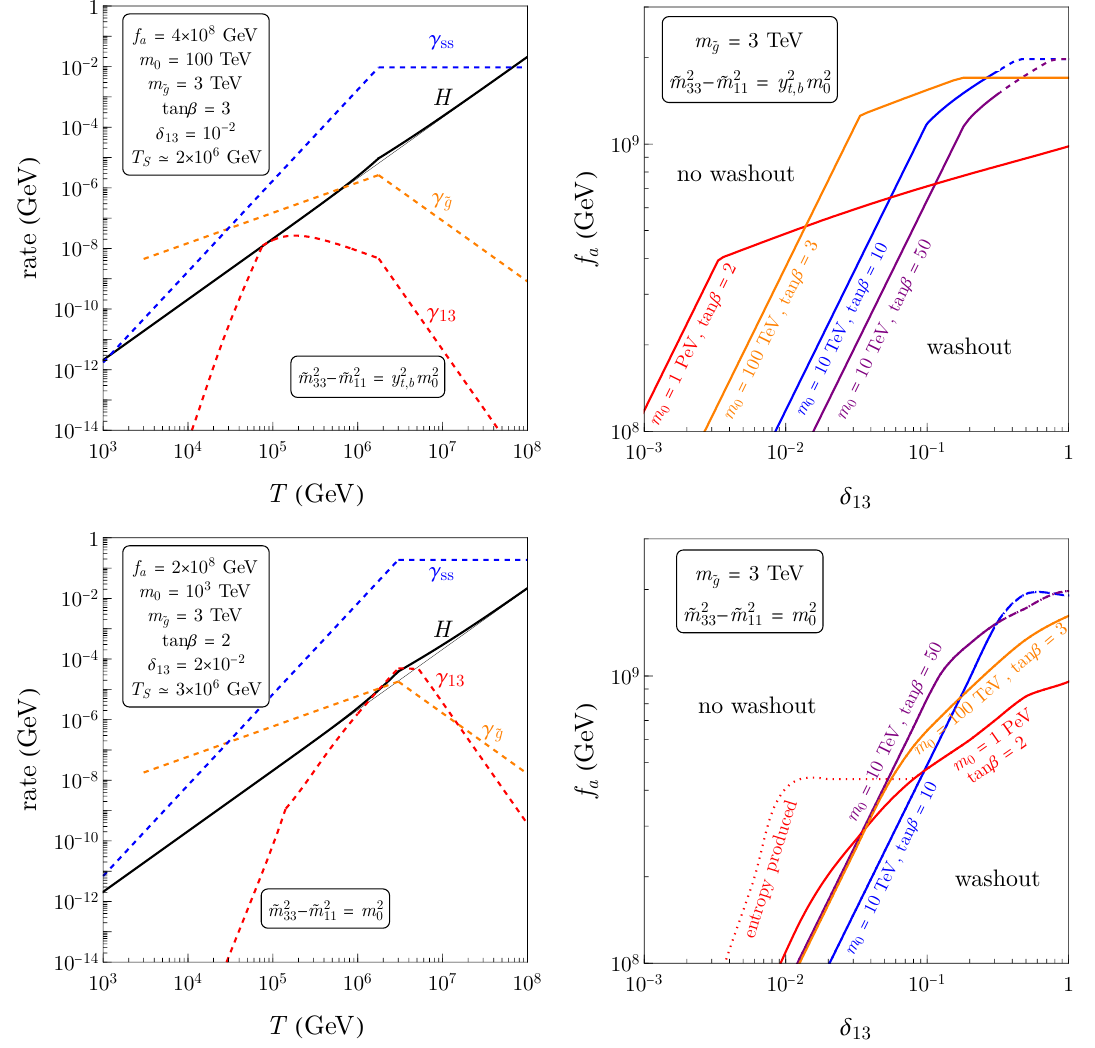
Figure 5 . Left: Hubble and the washout interaction rates as a function of temperature for bench- mark points where squark masses are nearly degenerate (top), or have O (1) splitting (bottom). Right: minimum values of f a required for different choices of m 0 and tan β to prevent washout for degenerate scalars (top) and O (1) splittings (bottom) as a function of squark mixing δ 13 , which we take as universal for left-handed and right-handed up and down squarks. Dashed segments indicate δ 13 that induce too-large FCNC in the B meson system. For m 0 = 1 PeV (bottom right panel), below the dotted line, partial washout of the axion rotation produces entropy; the estimation of the baryon asymmetry as well as the washout constraint will be modified. In right panels, the assumption that the KMM provides the dark matter fixes T S